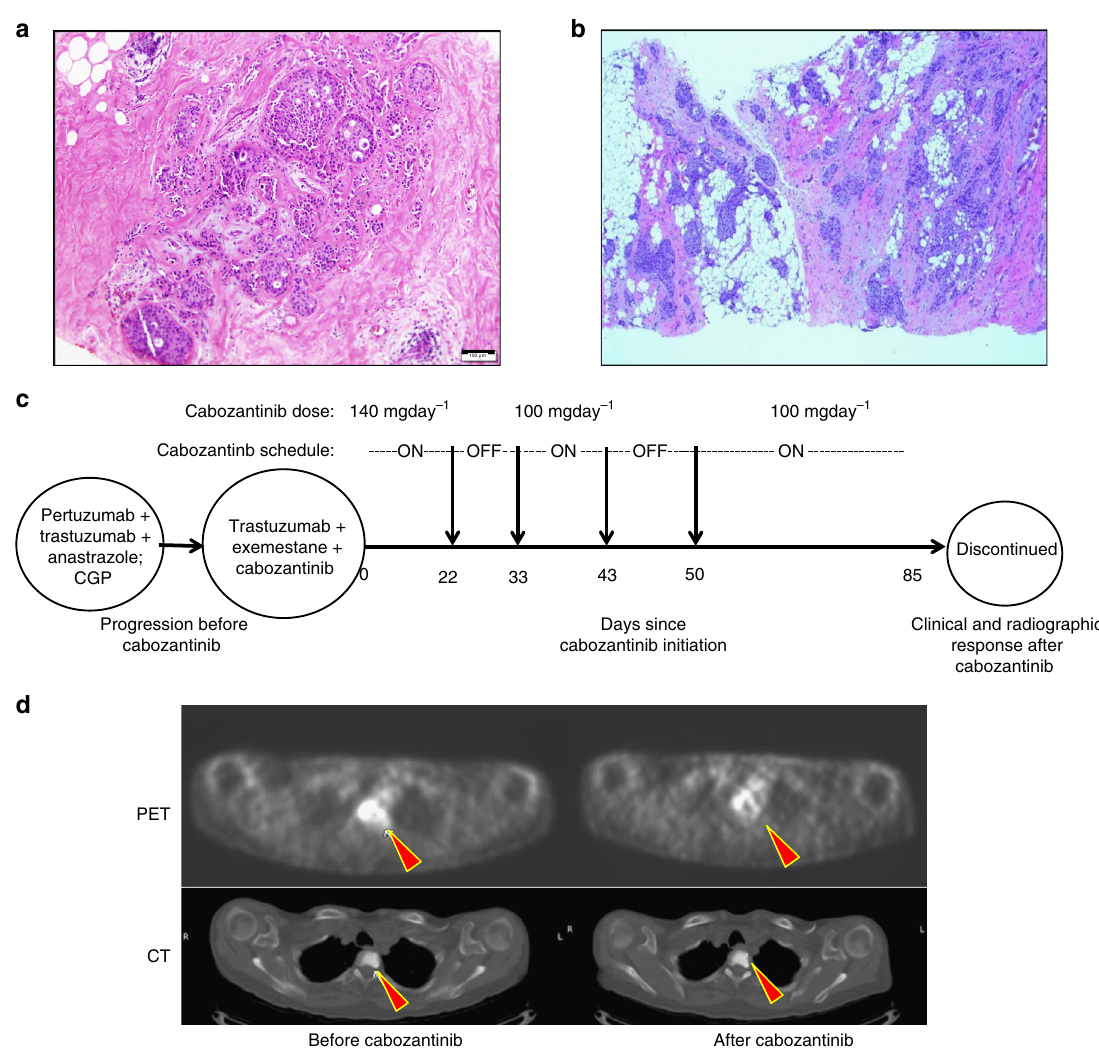
Fig. 6 Clinical response to targeted therapy in a patient with RET-fusion + ve breast cancer. a Histology image of stage I ER + /HER2 − tumor. Scale bar indicates 100 μ m. b Histology of the regional/distant recurrence of ER + /PR − /HER2 3 + tumor from the right axillary tail, ×4 magni fi cation. Genomic pro fi ling on this tissue revealed NCOA4-RET fusion (same as patient 3 in Fig. 1b). c Treatment schematic and timeline showing initiation of cabozantinib (day 0) after progressing on HER2-targeted treatment (pertuzumab, trastuzumab) and anastrazole. Targeted genomic pro fi ling identi fi ed the presence of NCOA4-RET fusion. Based on the fi nding, cabozantinib, a RET inhibitor, was added along with trastuzumab and exemestane as second-line treatment. Intermittent treatment and dose reduction was required due to side effects. Clinical and radiographic response was observed 85 days after cabozantinib initiation. d Representative PET (top row) and CT (bottom row) images of thoracic spine lesion ( fi lled red arrows) before and after cabozantinib